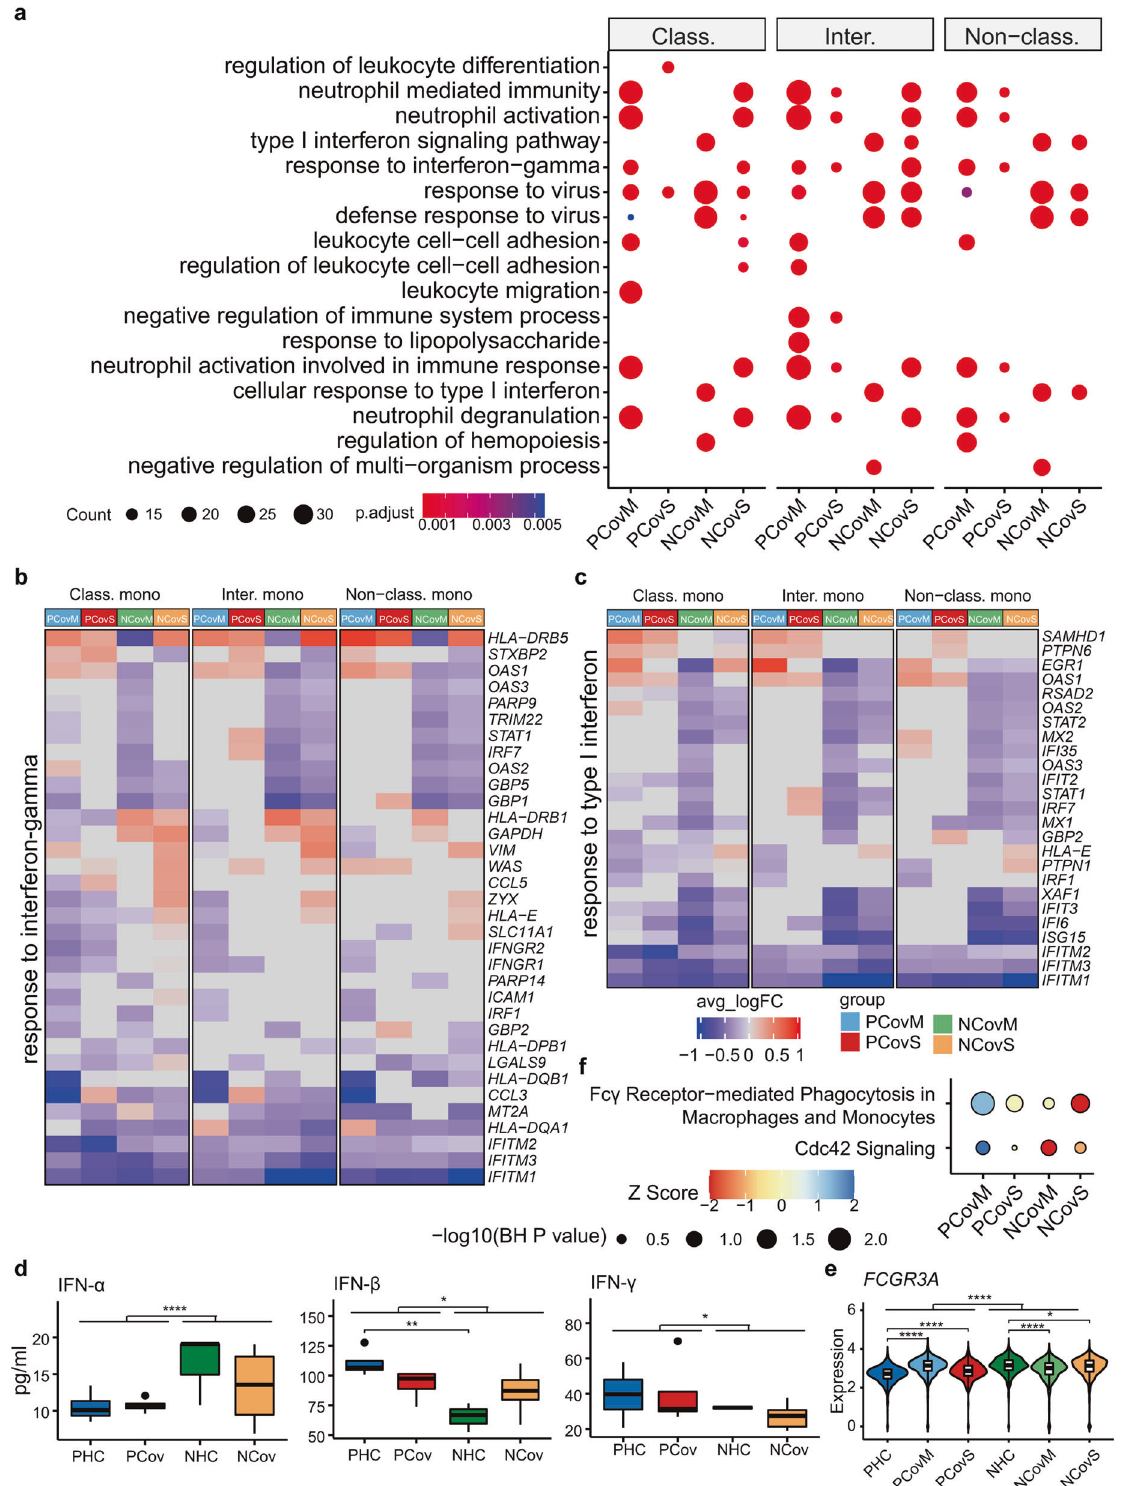
for 15 min, 95 °C for 3 min, followed by 45 cycles of 95 °C for 15 s and 60 °C for 30 s. Blood routine . Blood samples were collected in the vacuum tubes with EDTA as anti-coagulant (BD, Cat. No.367841) and analyzed by